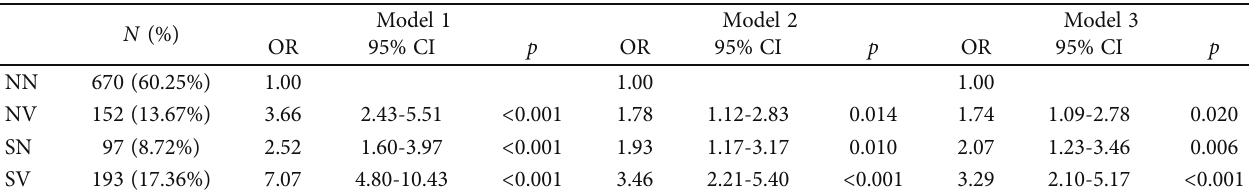
Figure 1: Prevalence of lean nonalcoholic fatty liver disease (NAFLD) across four phenotypes in patients with type 2 diabetes mellitus. Table 2: Associations between four phenotypes and prevalent lean nonalcoholic fatty liver disease in patients with type 2 diabetes